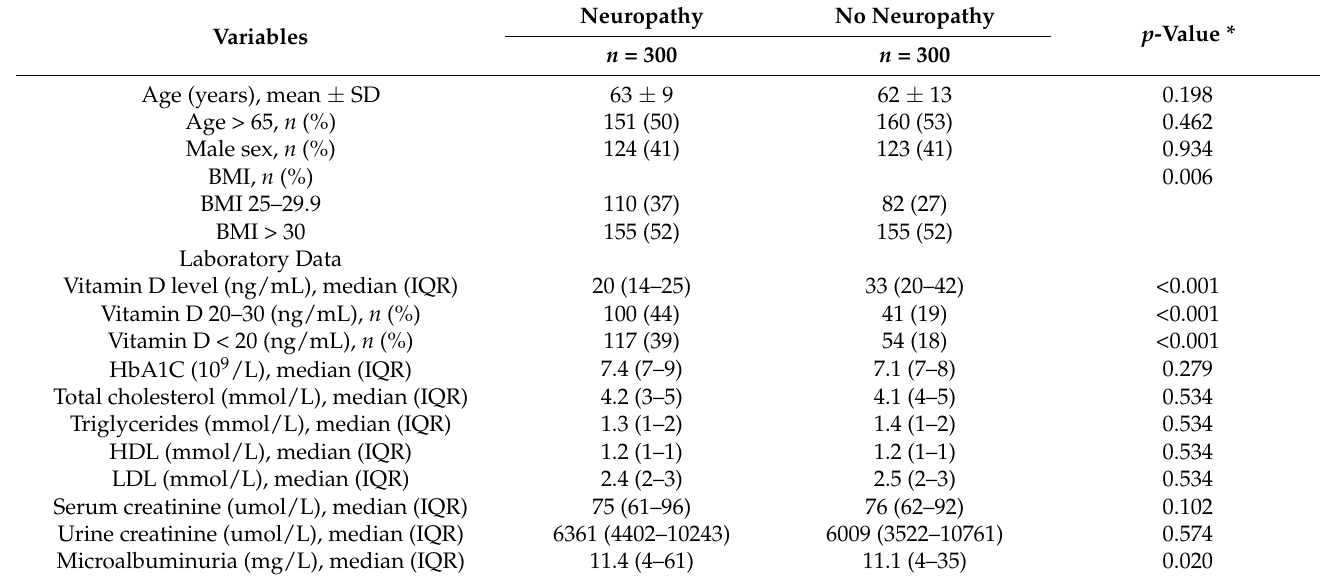
Table 3. Significant differences between group 1 (neuropathy) and group 2 (no neuropathy).